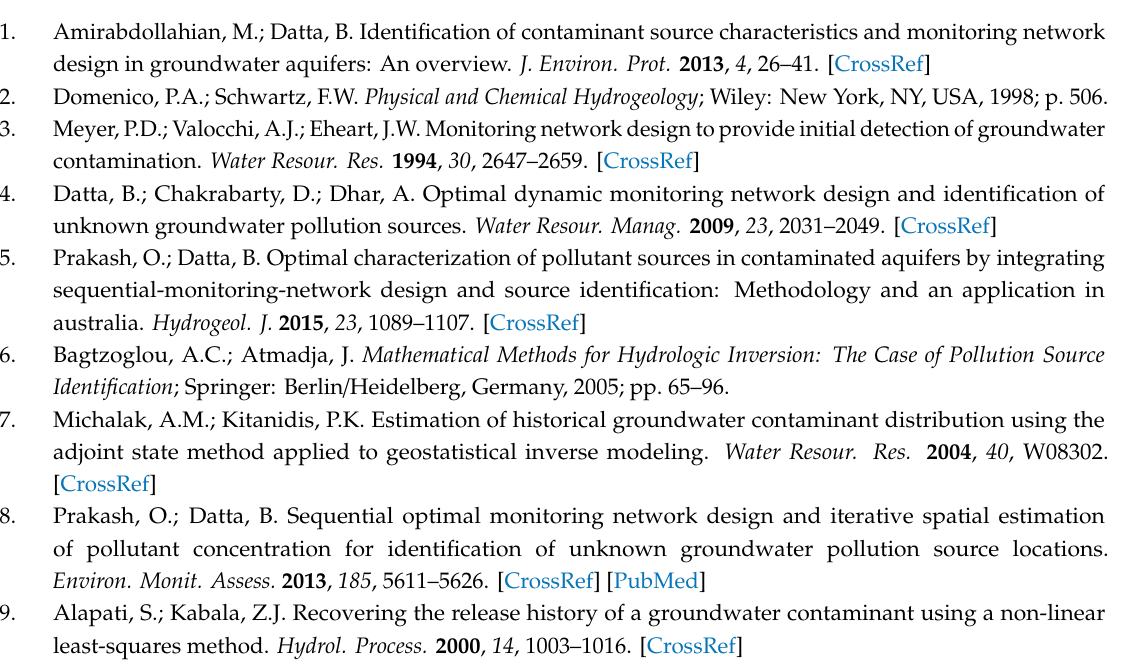
Figure S1: Cross sections location, Figure S2: Hydrogeological cross sections, Figure S3: Measured points fitted by Theis standard curve, Table S1: Pumping tests